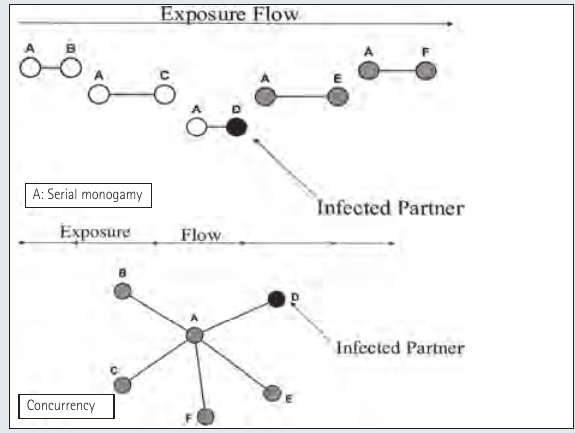
Fig. 2. In the serial monogamy scenario, after A is infected by partner D, up to two partners are put at risk of HIV. In the concurrency scenario, all four other partners are placed at risk (black circle = HIV infected, grey circle = at risk of HIV infection) (figure based on Wohlfeiler and Potterat 29 ).